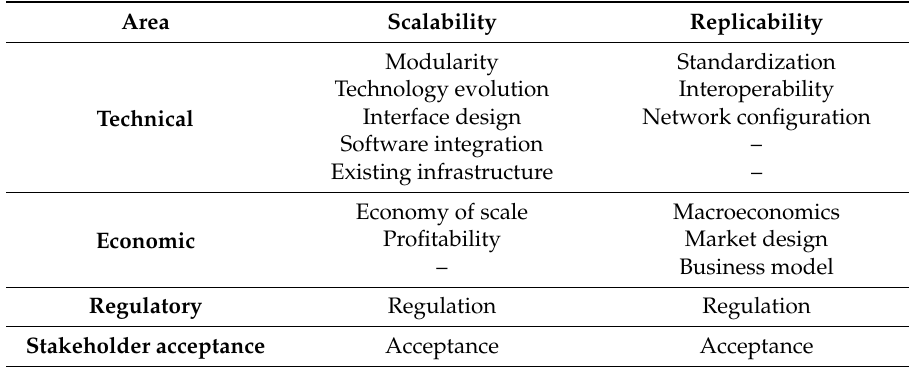
Table 1. Summary of the